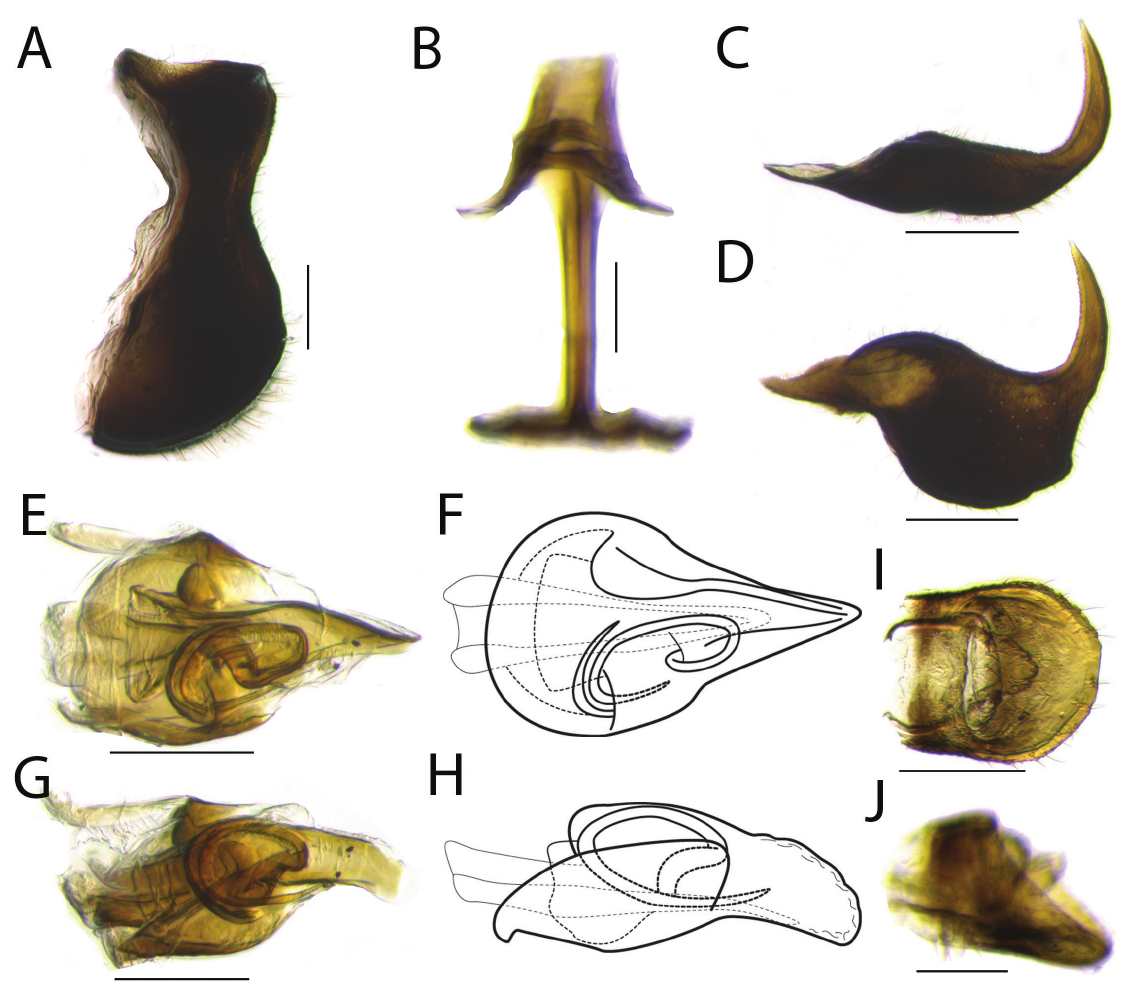
Fig. 22. Male terminalia of Protrocha nigrilutea sp. nov., holotype (INHS). A . Pygofer, lateral view. B . Connective, anterior view. C–D . Style. C . Dorsal view. D . Lateral view. E–H . Phallus. E–F . Dorsal view. G–H . Lateral view. I–J . Anal tube. I . Dorsal view. J . Lateral view. Scale bars = 0.1